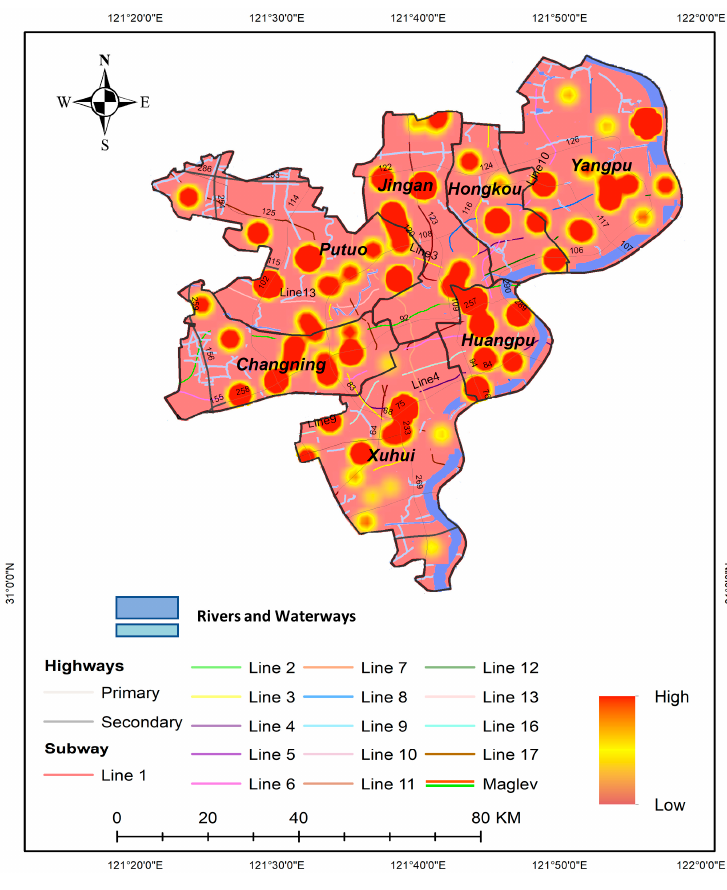
Figure 7. Check-in density.